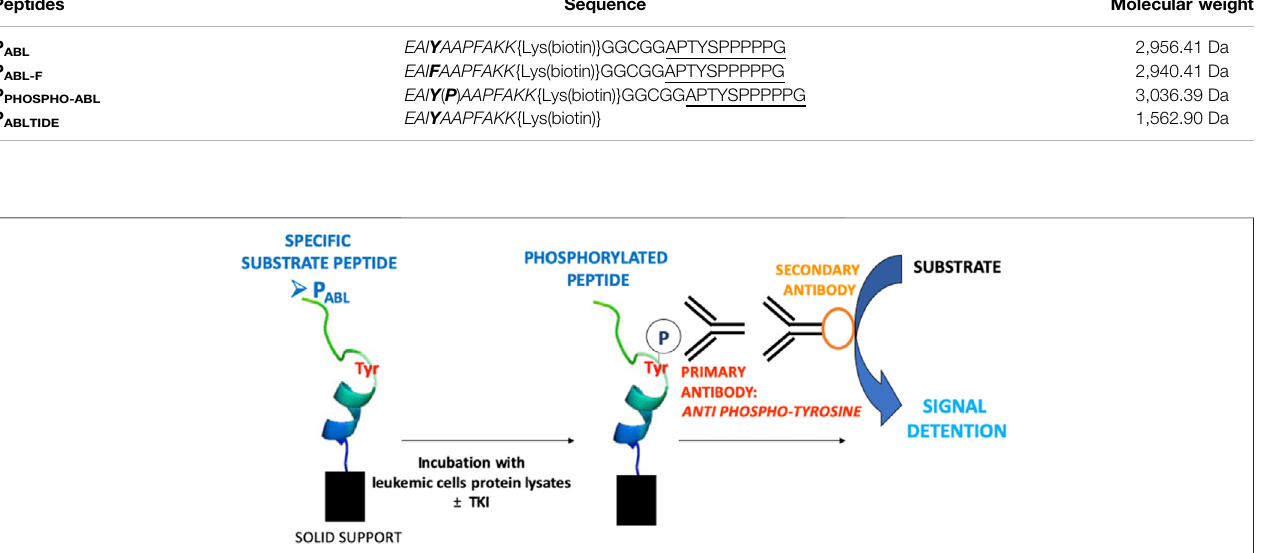
TABLE 1 | Biosensor peptides employed in ELISA assay, their sequence and molecular weight. The “ reporter ” sequence is shown in italic, and the “ targeting ” sequence is underlined. In the phosphorylation site of ABL1, tyrosine and peptide modi fi cations are shown in bold. Peptides